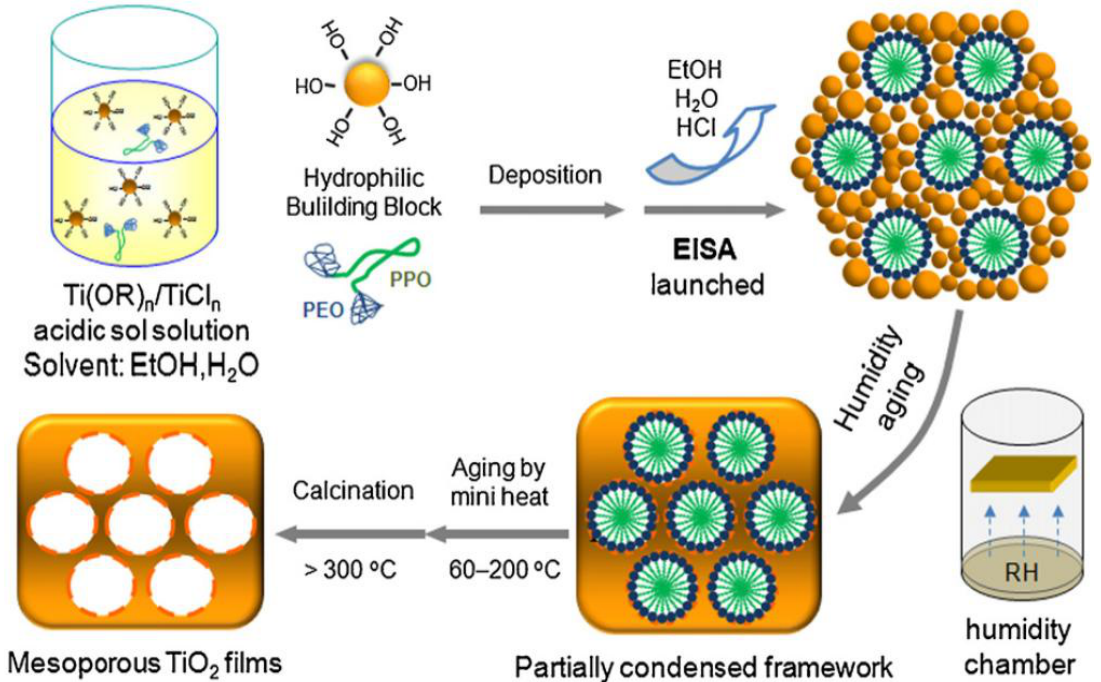
Figure 3. Schematic representation of the formation of mesoporous titania thin film. Reprinted with permission from [28]. Copyright 2011